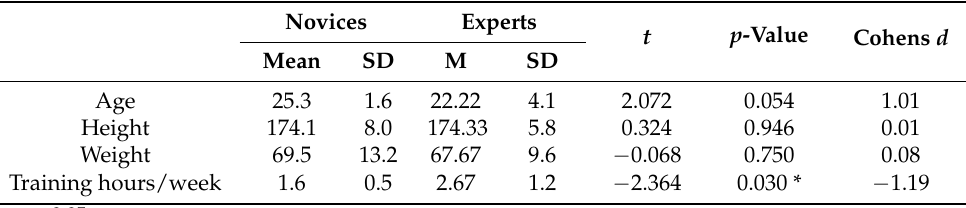
Table 1. Characteristics of the two groups (novices; experts) of the study population and group differences measured by t -test.